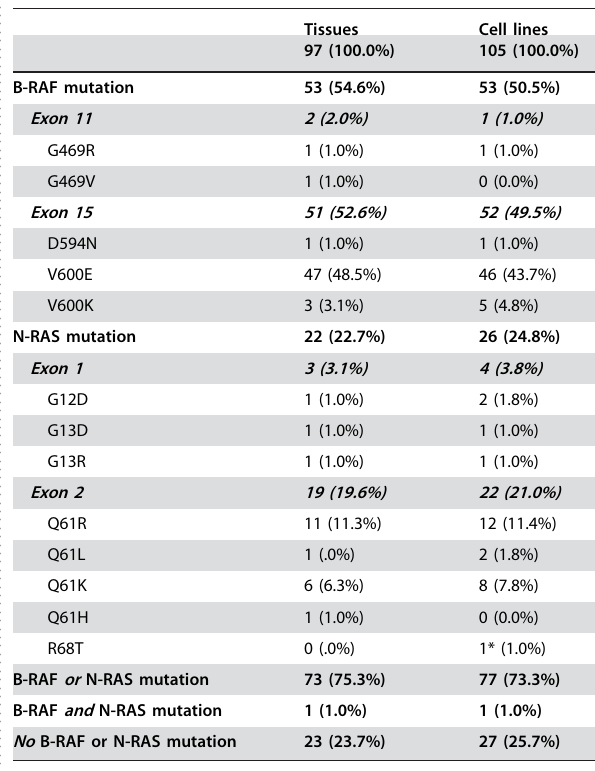
Tumor tissue biopsies and biopsy-derived cell lines from 109 metastatic melanoma patients were analysed for B-RAF and N-RAS mutations. For details see Figure 1 and Table 2 . *This cell line additionally carries the N-RAS Q61K